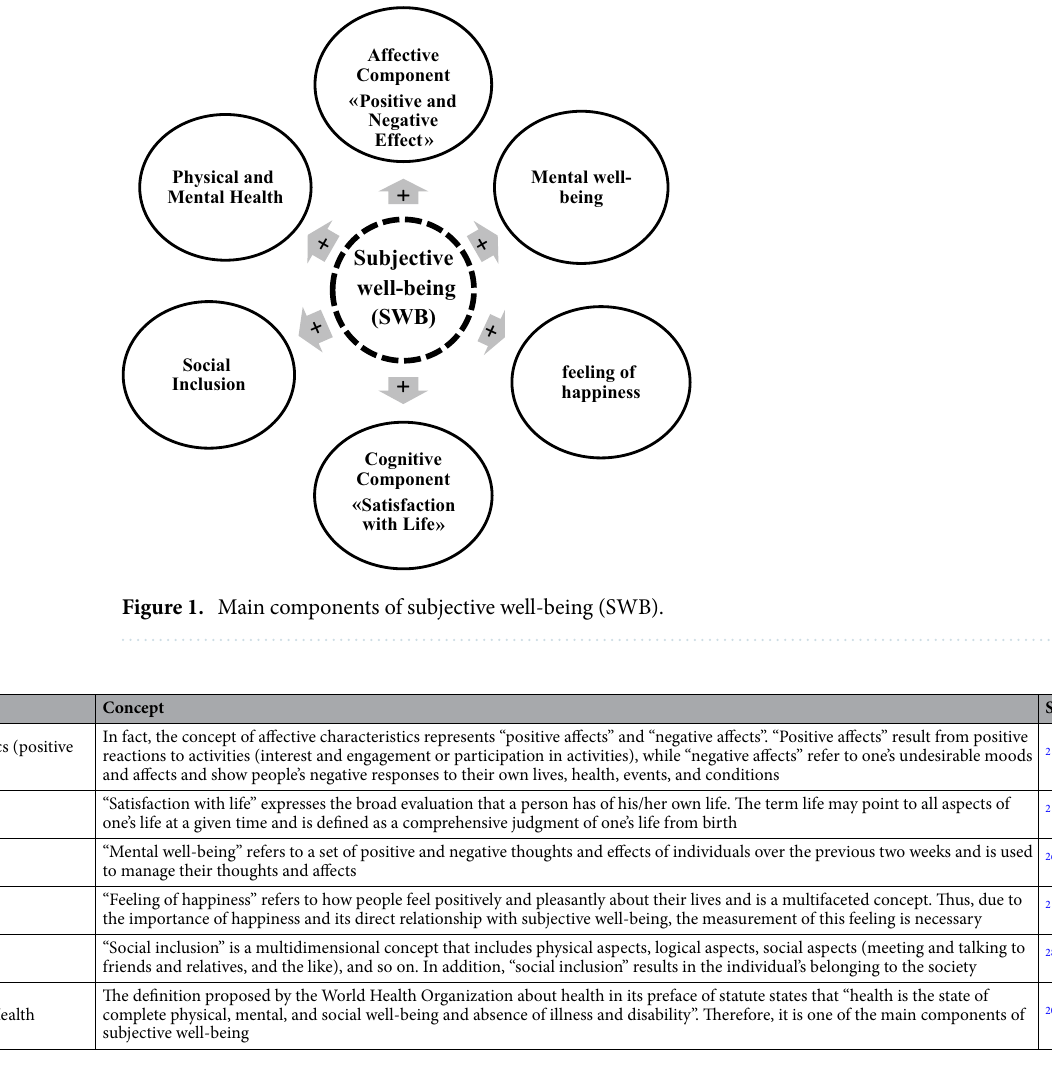
Table 3. Explaining the components consisting of citizens’ subjective